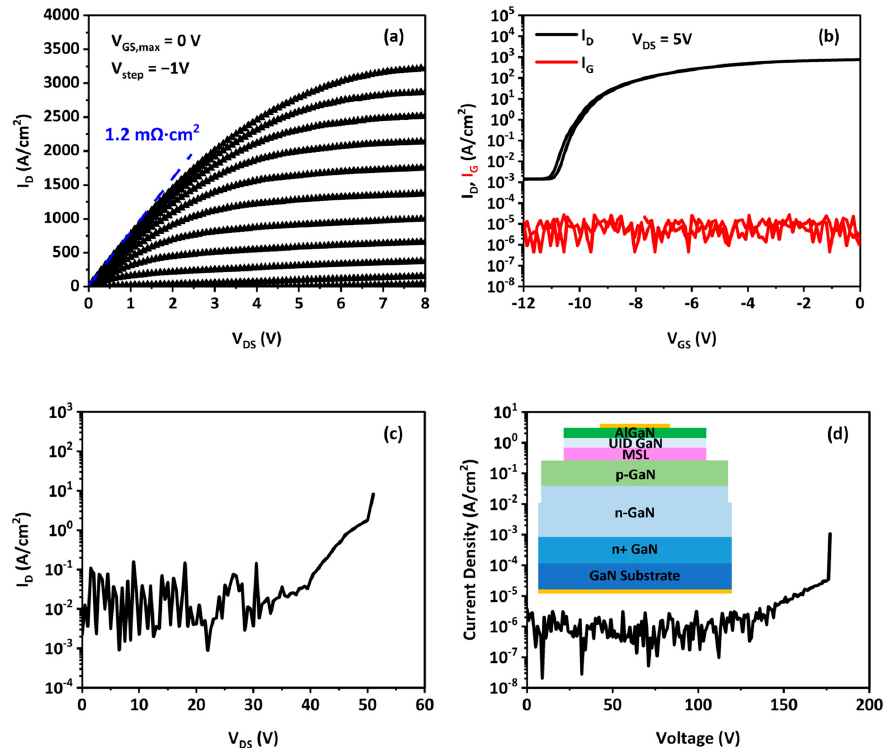
Figure 5. ( a ) I D − V DS output characteristics, ( b ) I D − V GS transfer characteristics, and ( c ) o ff -state char-